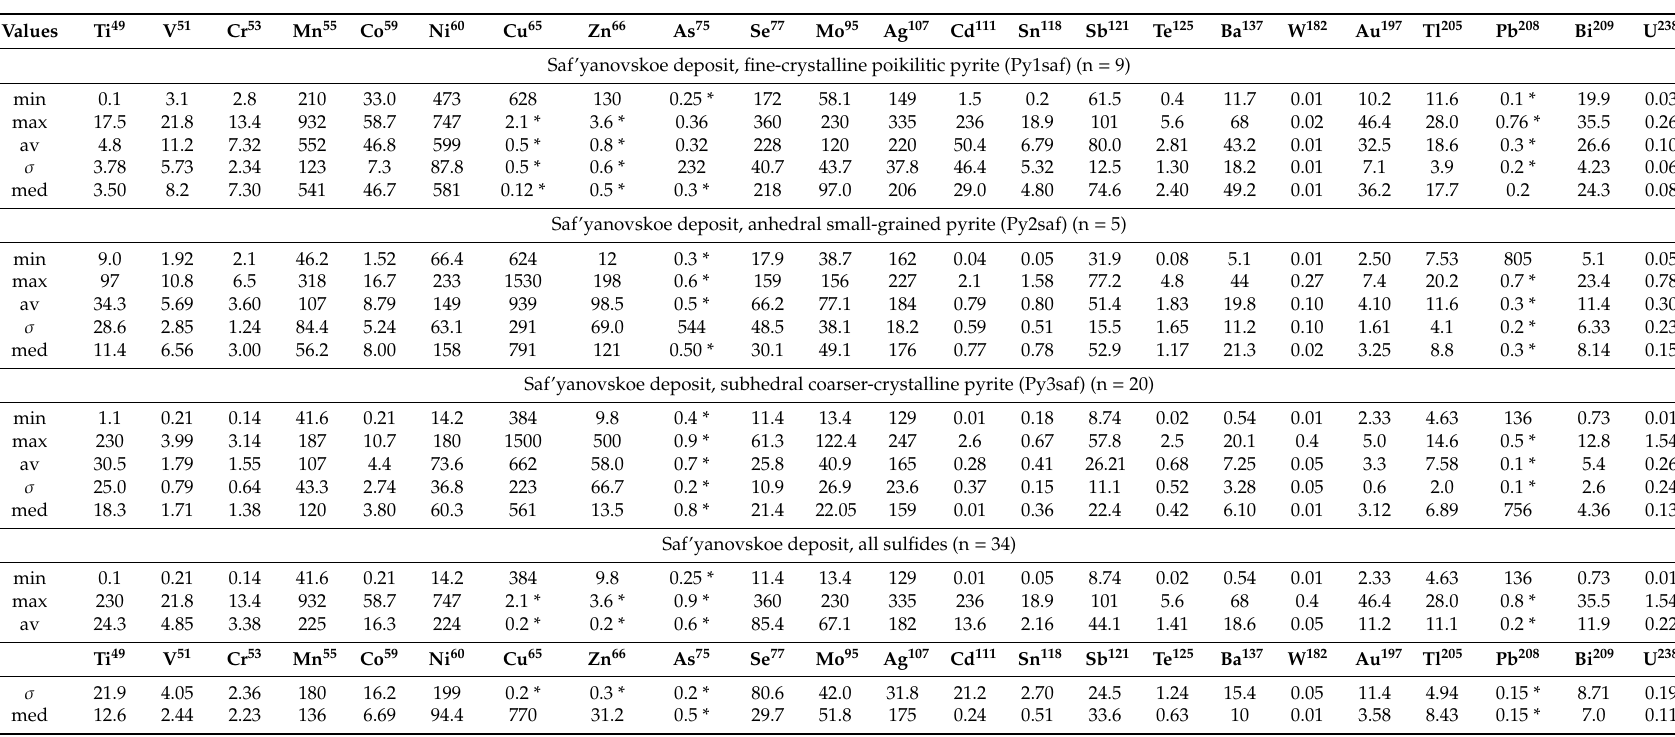
Table 1. Trace element content (ppm) of pyrite and pyrrhotite of the nodules from Saf’yanovskoe, Talgan, and Dergamysh massive sulfide